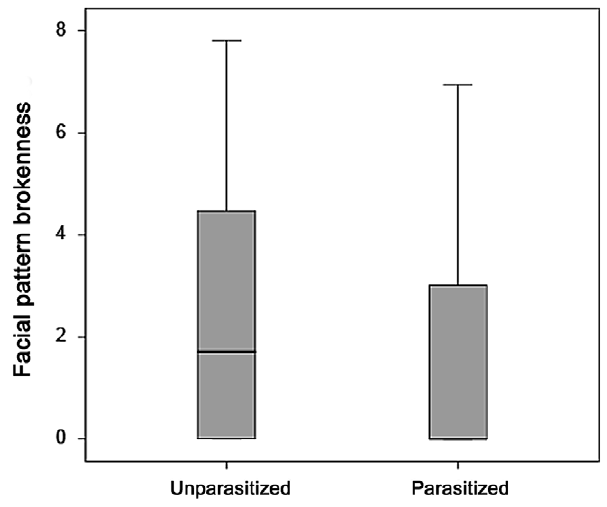
Figure 5. Facial pattern brokenness of parasitized vs. not- parasitized P.dominulus in the Italian and Hungarian popula- tions. Parasitism is associated with lower facial pattern brokenness. Box indicates the 25 th , 50 th , and 75 th percentile, while the whiskers reflect the 95% confidence interval.